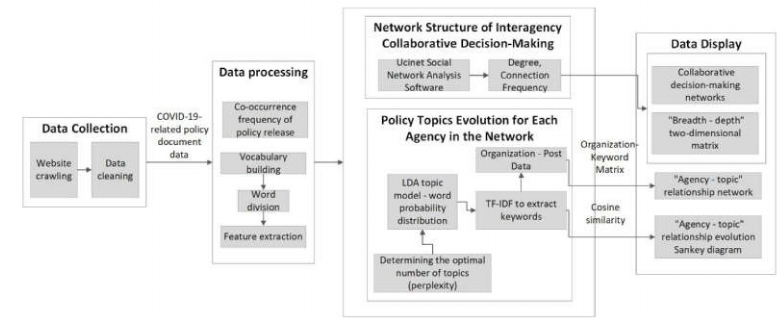
Figure 1. Research methods